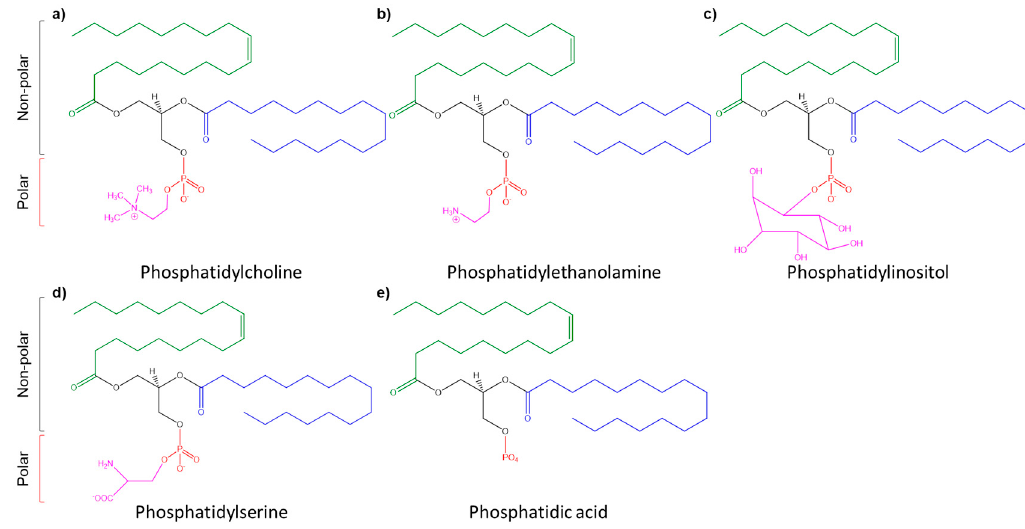
Figure 1. Chemical formulas of different phospholipid-derived lecithin. Shown in red—phosphate group; green—monounsaturated fatty acid; blue—saturated fatty acid; pink—choline ( a ), ethanolamine ( b ), inositol ( c ), serine ( d ), and glycerol ( e ).